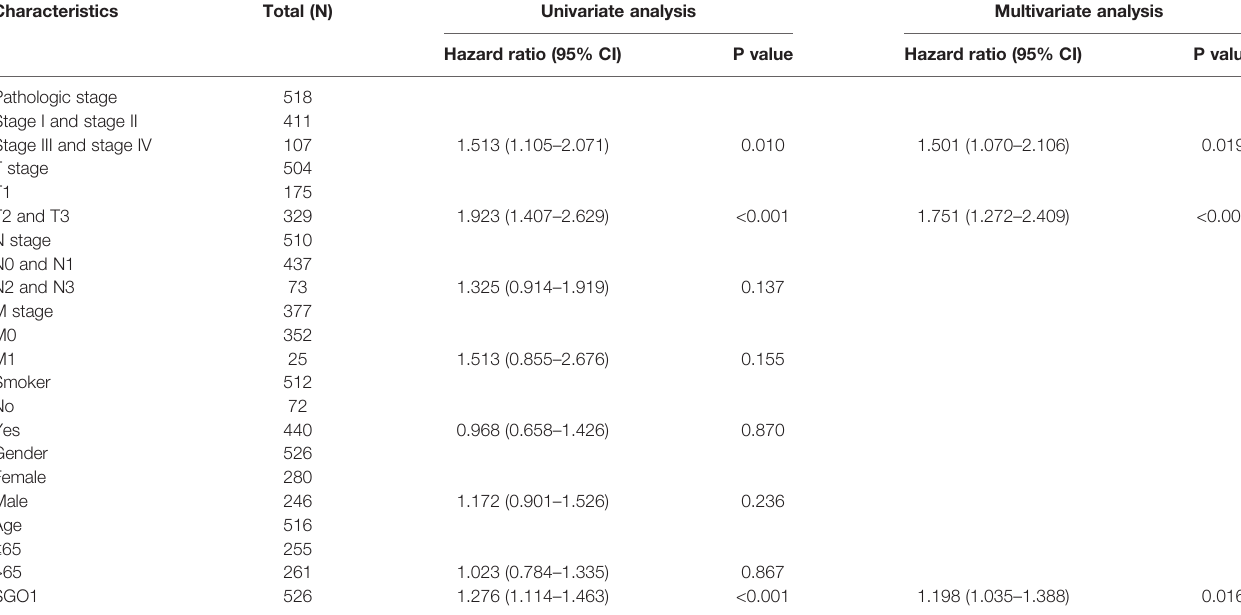
TABLE 5 | Univariate and multivariate Cox regression analyses of different parameters on progression-free survival in LUAD.